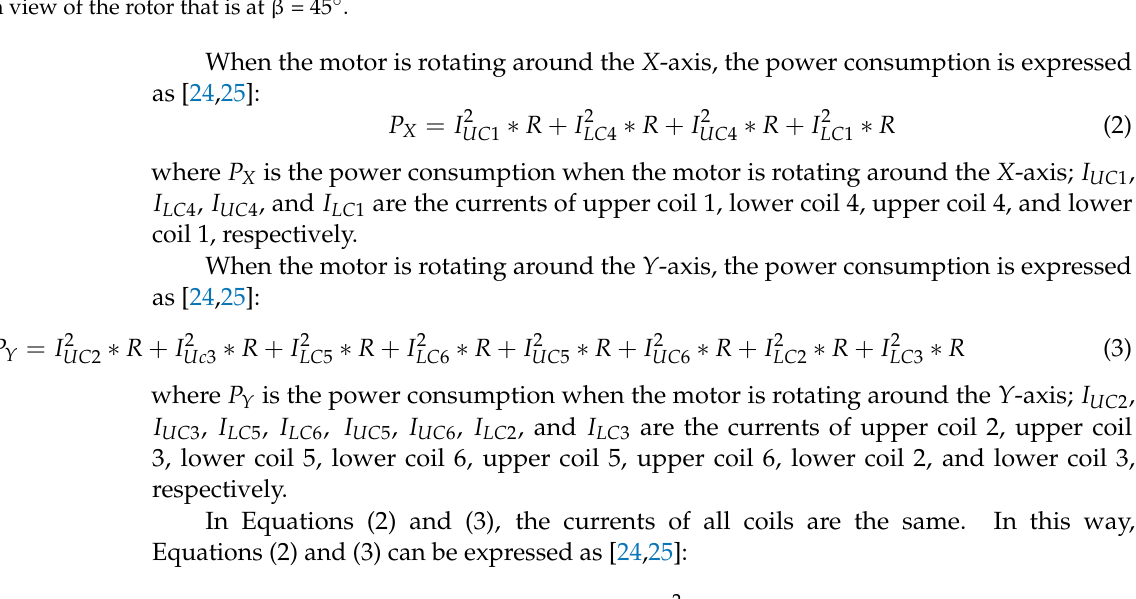
Figure 4. The working principle for the motor rotating around the Y ‐ axis: ( a ) top view of the rotor that is at β = 45°; ( b ) XZ cross ‐ section view of the rotor that is at β = 45°.